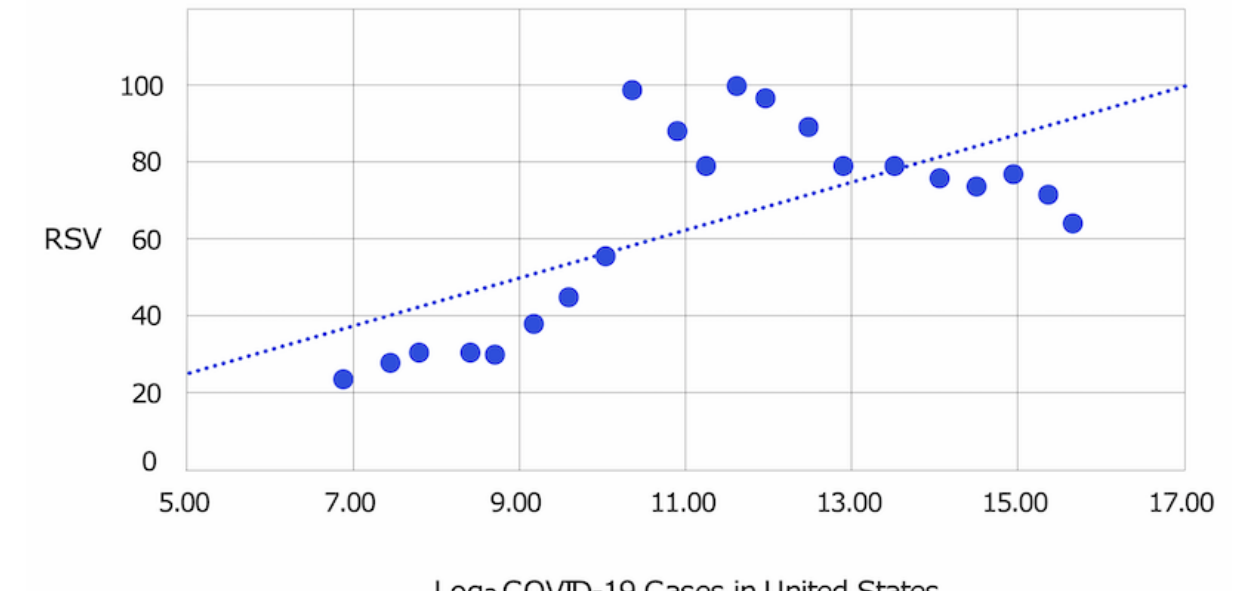
Figure 5. Cases of COVID-19 data linearized using logarithmic transformation with base of 2 graphed against the RSV for the Google search term coronavirus . A linear relationship was assumed, and a model was fit. RSV: relative search